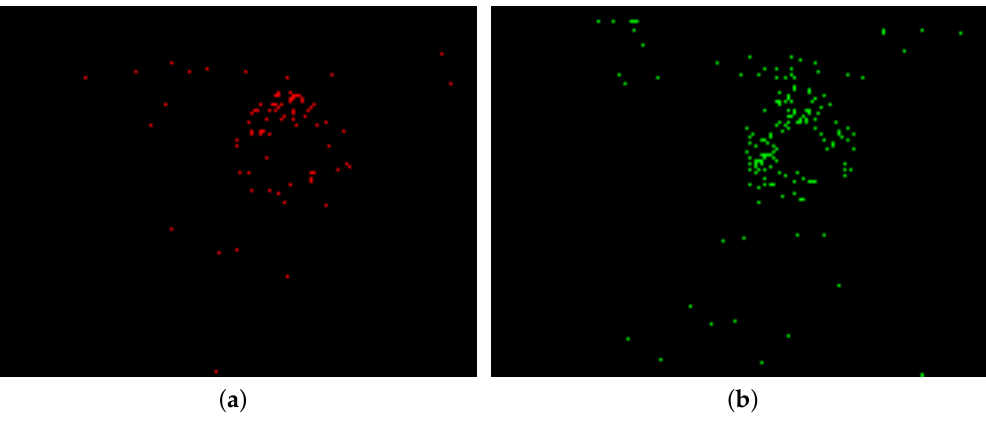
Figure 3. ( a ) negative-polarity events during the grasping phase; ( b ) positive-polarity events during the releasing